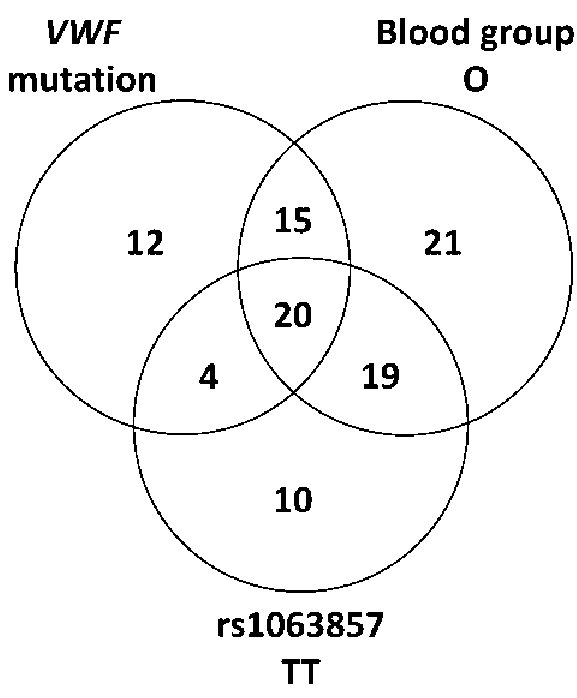
Fig. 2 The presence of von Willebrand factor (VWF) mutations, blood group O, and the TT genotype of rs1063857 in the 106 von Willebrand disease type 1 index